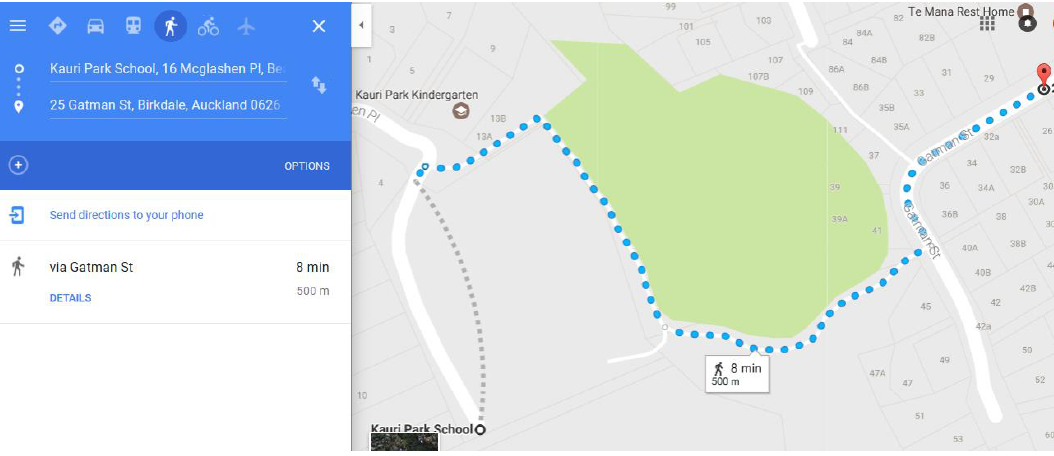
Figure A3. Distance on Foot Example .